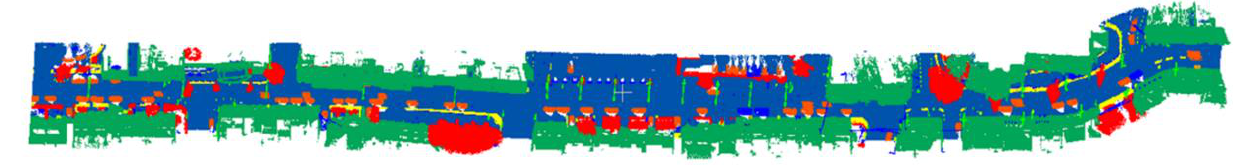
Figure 7. Part of Paris-Lille-3D dataset.